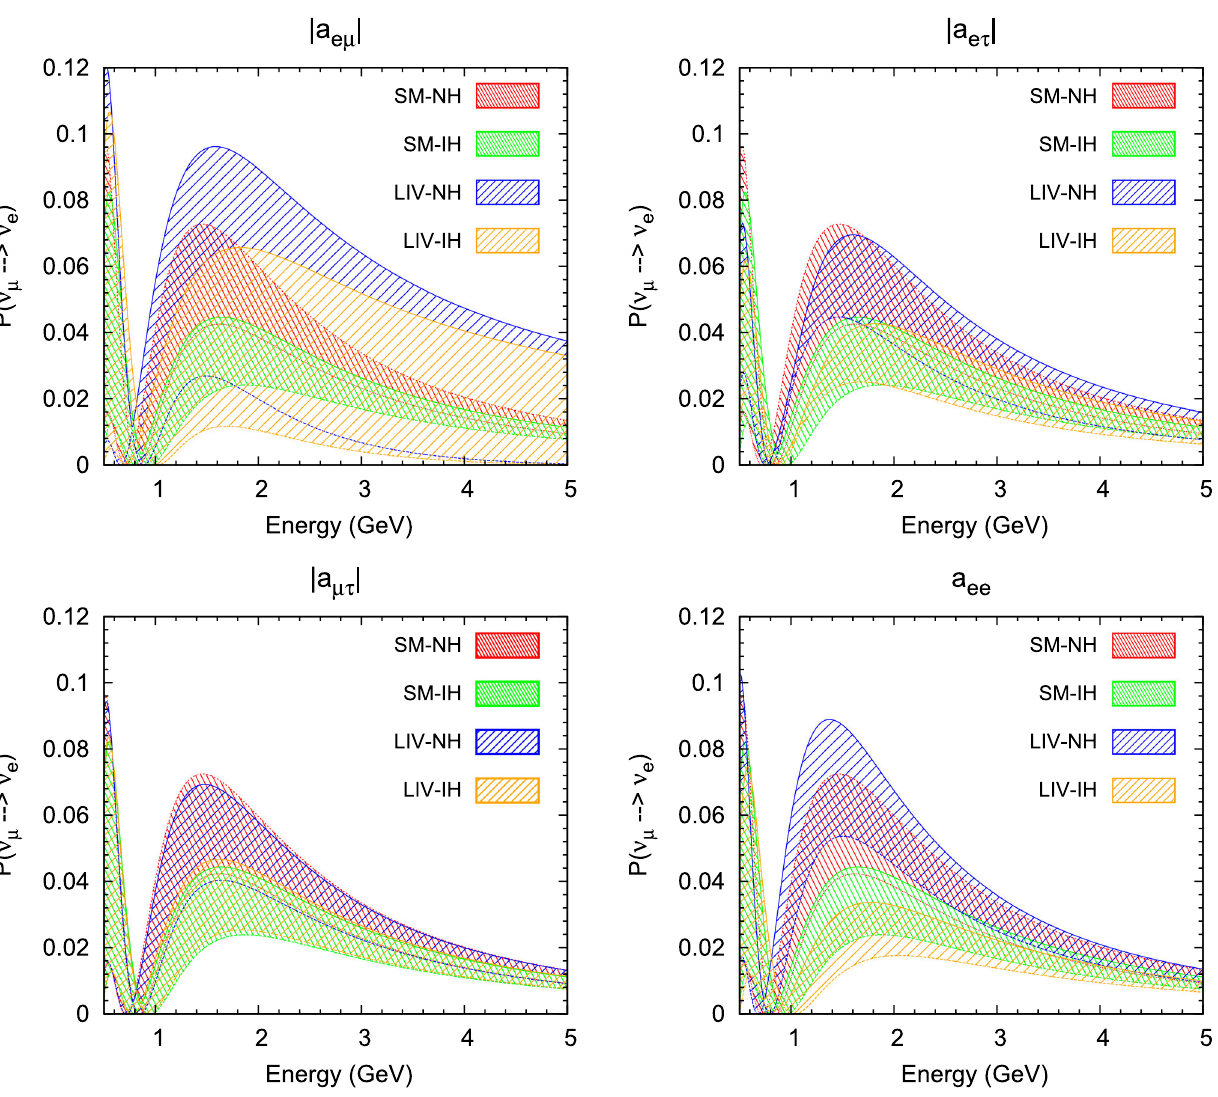
Fig. 6 The oscillation probability for NO ν A experiment as a function of energy in presence of non-diagonal LIV parameters | a e μ | , | a e τ | and | a μτ | are shown in top-let, top-right and bottom-left panels respectively. The effect of diagonal LIV parameter a ee shown in bottom-right